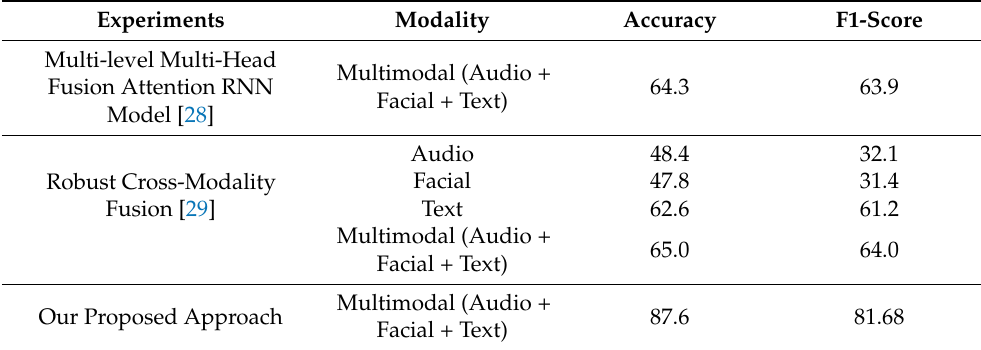
Table 3. Comparative study of proposed model with existing work on multimodal